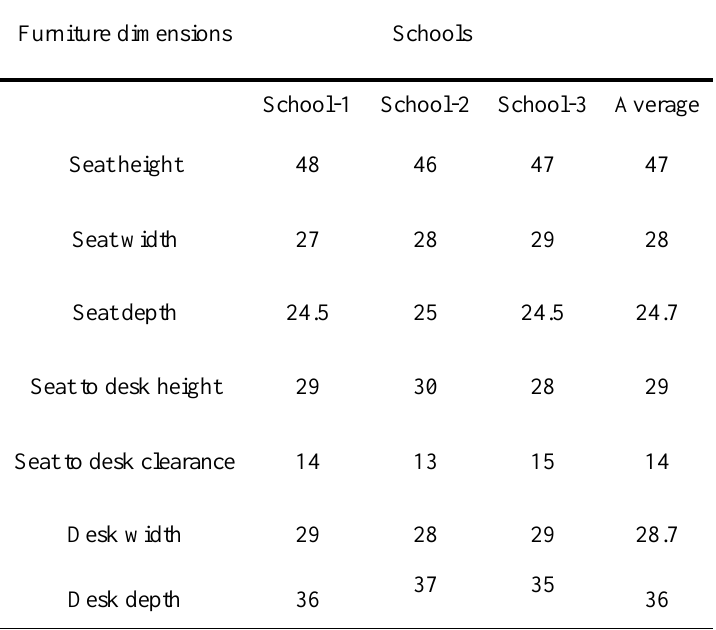
Table 3. Dimensions (cm) for existing classroom